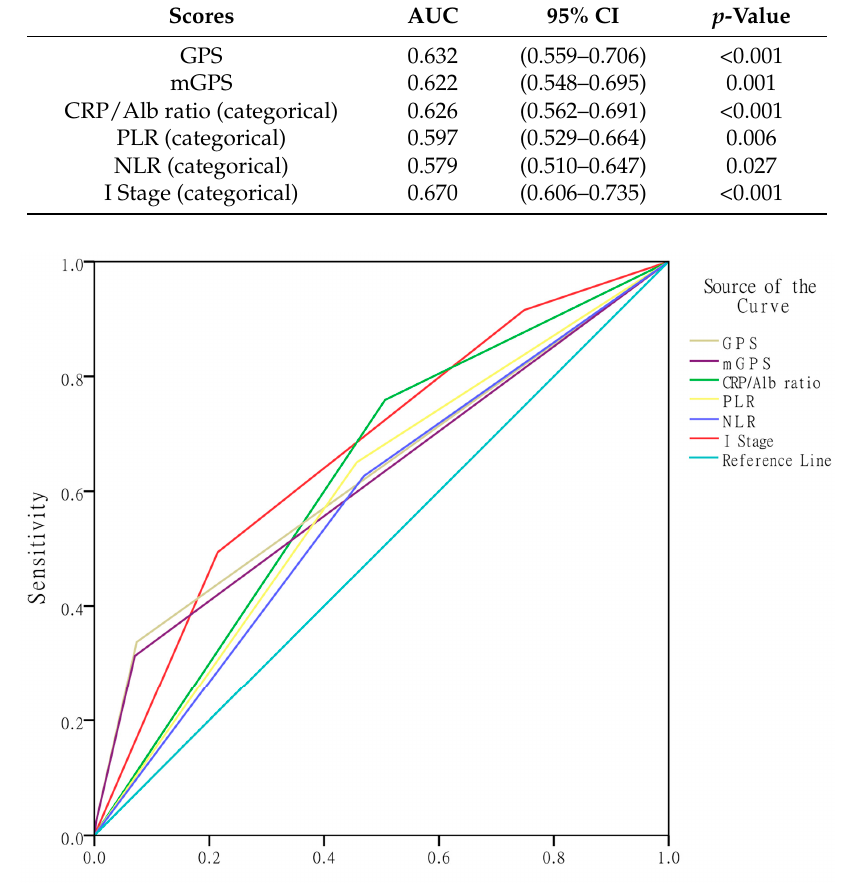
Figure 2. Comparison of the discriminatory ability of the I stage with GPS, mGPS, CRP/Alb ratio, PLR, and NLR.